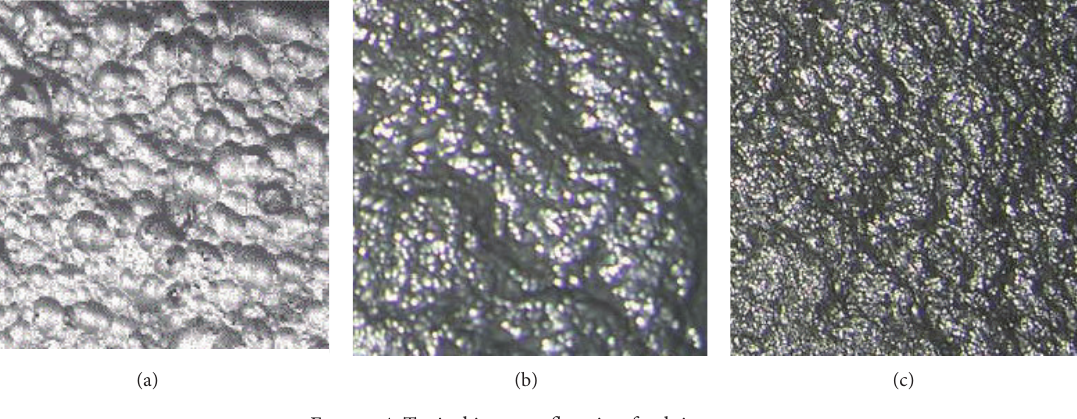
Figure 4: Typical iron ore flotation froth images.